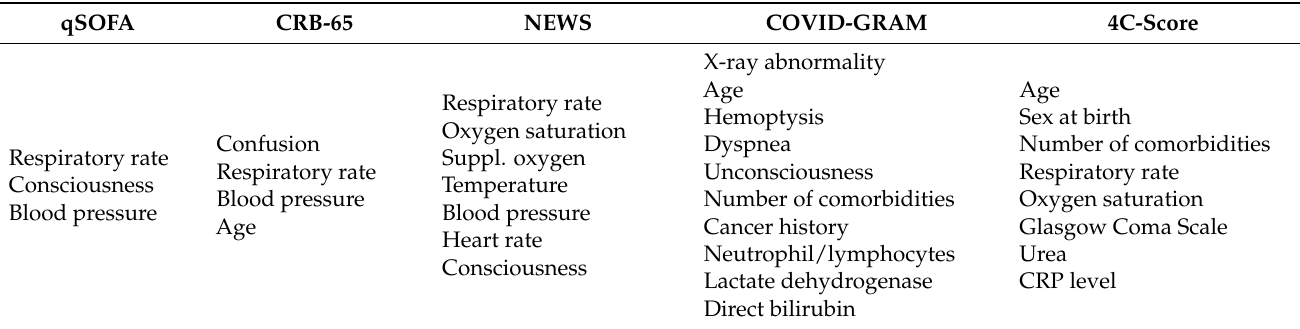
Table 2. Parameter of risk